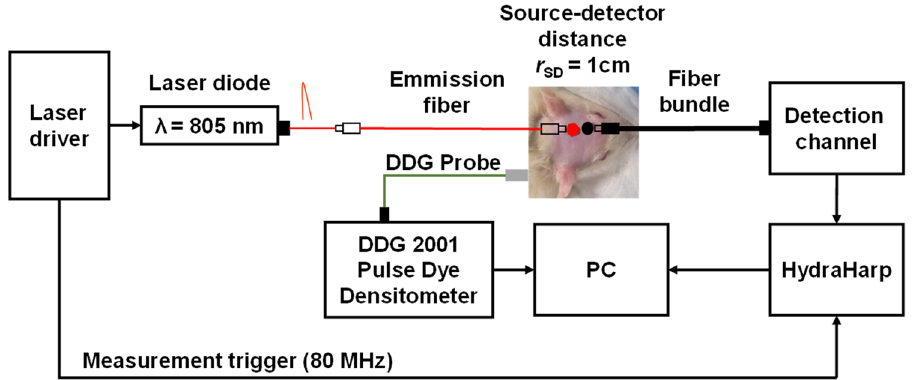
Figure 5. Schematic of the TR-NIRS system. Short pulses of light at 805 nm are generated (80 MHz) and guided to the rat’s head by an optical fiber. Another fiber bundle directs diffusively reflected light from the head to fast detectors coupled to a counting board